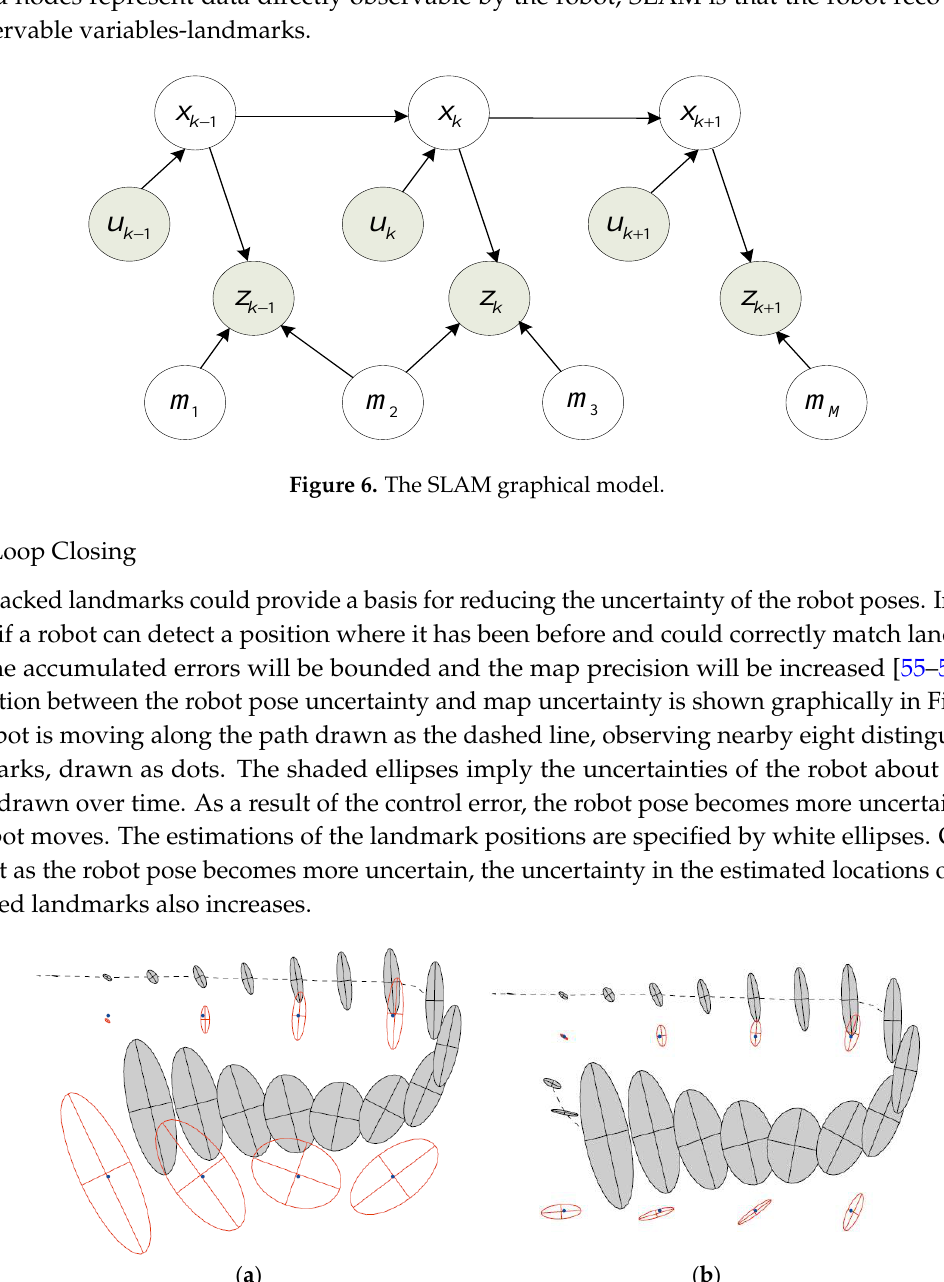
Figure 7. ( a ) Before closing the loop; ( b ) After closing the loop.